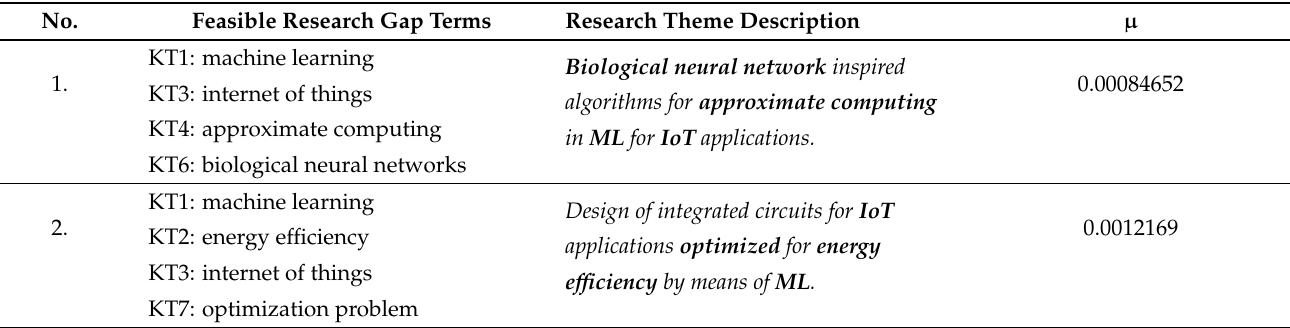
Figure 6. Visualization of feasible research gaps using chord diagram. Table 2. Potential research topics in the EDA